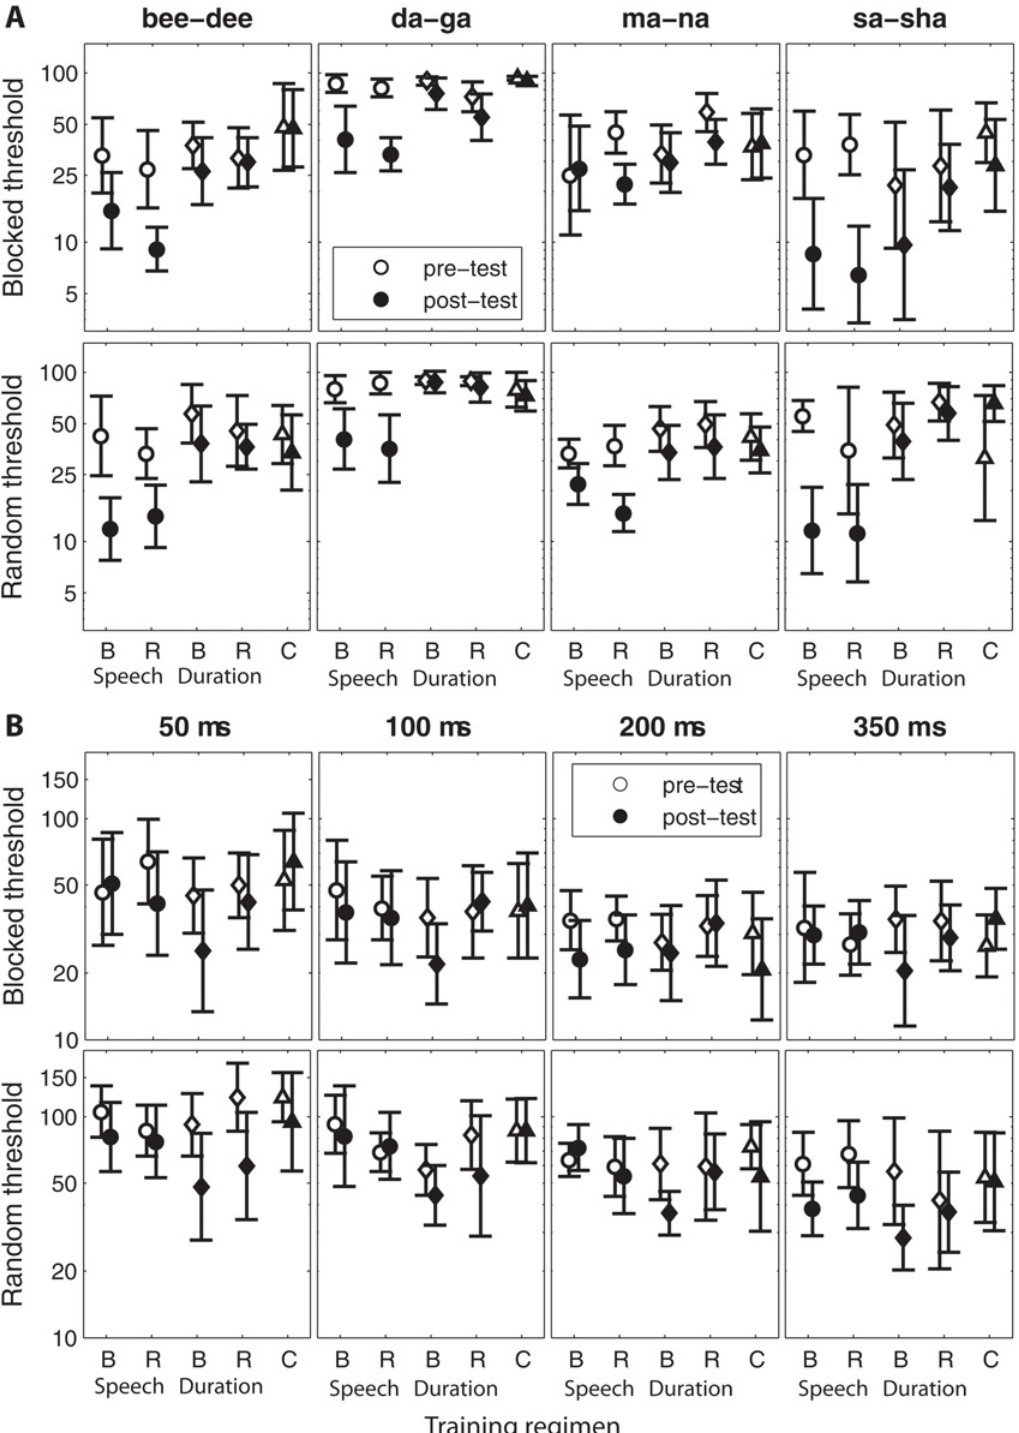
Fig 1. Pre- and Post-test thresholds for each training stimulus, stimulus class and testing mode. (A) Pre-test (empty symbols) and post-test (full symbols) thresholds on the speech discrimination task for each phoneme minimal-pair stimulus. Thresholds are plotted as the phoneme number (on the continuum between 1 and 96), tested on the blocked condition (top panels) and random mode (bottom panels). Five training groups (shown from left to right on the x-axis of each panel) were tested on each mode: Blocked (B) and Random (R) Speech, Blocked (B) and Random (R) Duration, and untrained Controls (C). Note that the top and bottom panels denote different training groups (10 groups in total; see Methods for details). All error bars denote 95%